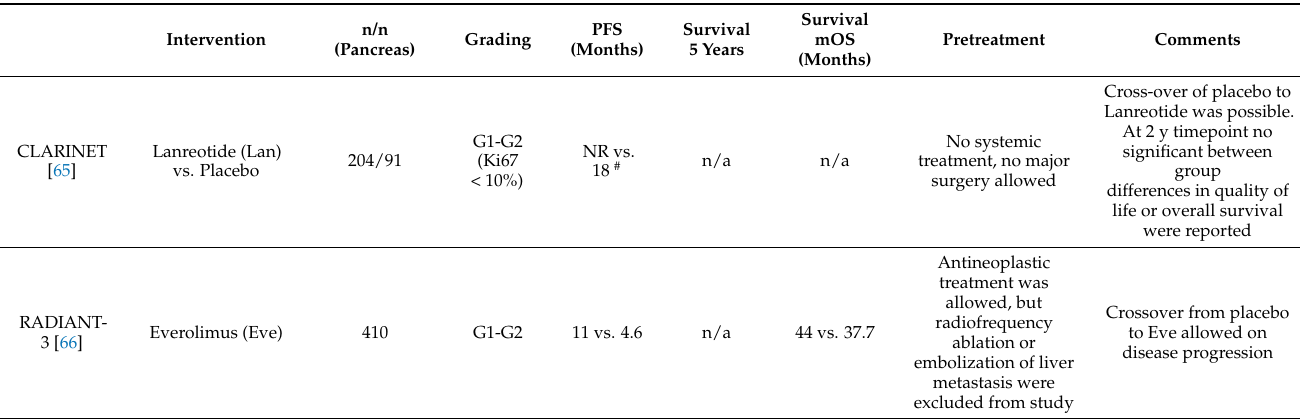
Table 3. Systemic treatment with responses in advanced